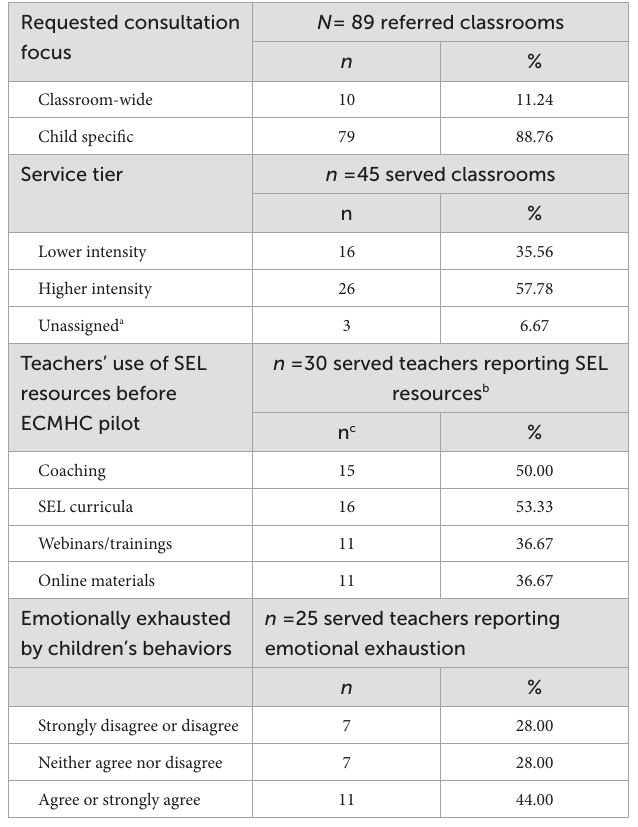
TABLE 1 ECMHC pilot